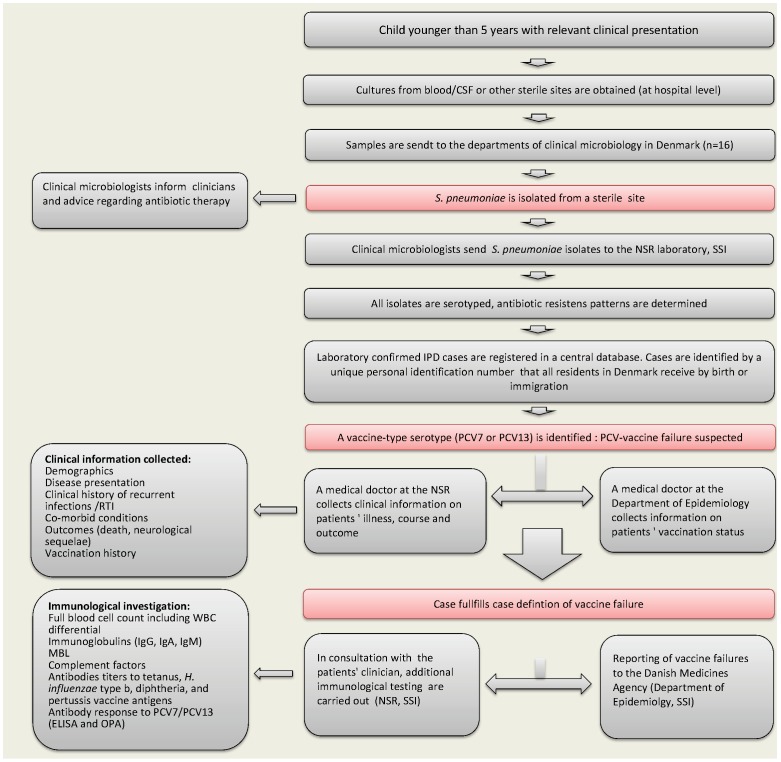
Danish surveillance system of pediatric invasive pneumococcal disease (IPD) and pneumococcal conjugate vaccine (PCV)-failures.Cases of IPD caused by a serotype included in PCV7 or one of the additional serotypes included in PCV13 are identified among all IPD cases in children <5 years in order to explore possible cases of vaccine failure. PCV7 was administered in the national childhood immunization program free of charge from October 1, 2007 to April 19, 2010 and then PCV13 was offered. CSF: Cerebrospinal fluid; NSR: National Neisseria and Streptococcus Reference Center, Statens Serum Institut: SSI, MBL: Mannose-Binding Lectin, RTI: Respiratory Tract Infections, WBC: White Blood Cells.